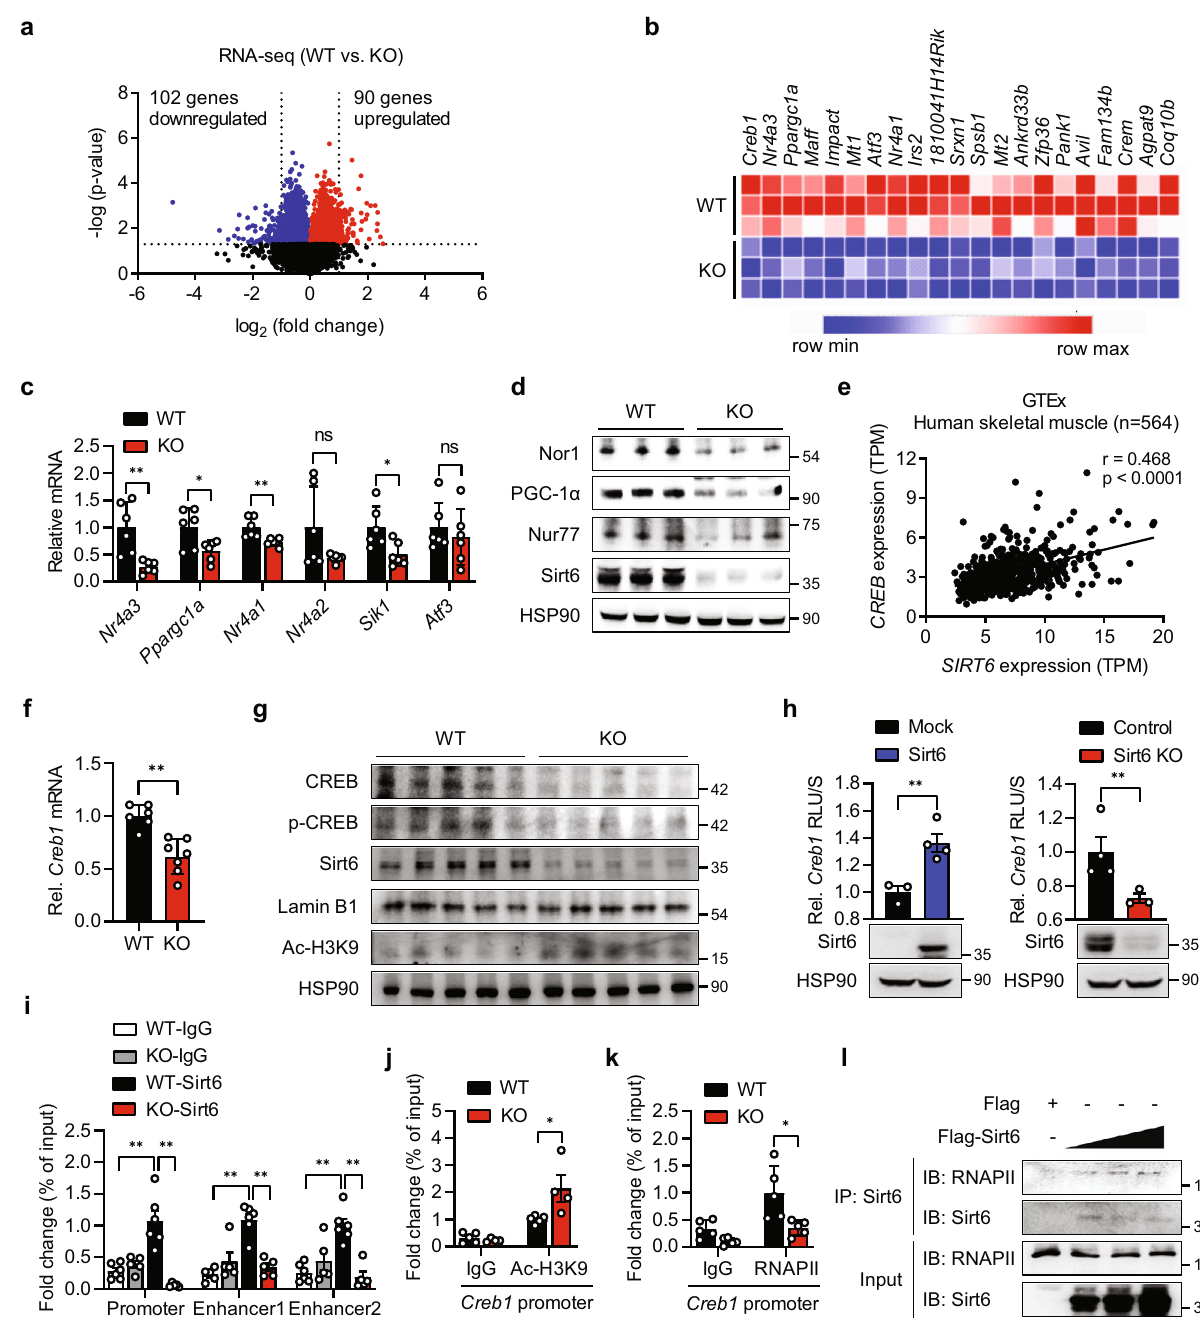
Fig. 4 Decrease in CREB pathway in muscle of Sirt6 KO mice. a Volcano plot showing the log 2 fold-difference in mRNA expression in gastrocnemius muscles (GAS) of WT and Sirt6 KO mice, assessed by StringTie analysis of RNA-seq data. Red and blue dots represent upregulated and downregulated DEGs with > 2-fold change and p < 0.05, res p ectively. Each sample was analyzed in triplicate. b Heat map of RNA-seq analysis of Creb1 and top 20 downregulated genes. c , d qPCR and Western blotting analyses of CREB target genes in GAS of mice ( n = 6). e Genotype tissue expression (GTEx) analysis of human skeletal muscle. Pearson correlation coef fi cient ( r ) between SIRT6 and CREB in human skeletal muscle were calculated. TPM, transcripts per million. f , g Creb1 mRNA and levels of the indicated protein in GAS of mice ( n = 6 for WT, n = 7 for KO). h Creb1 -luciferase reporter activities in HEK293T cells overexpressing Sirt6 or in cells with CRISPR/cas9 mediated Sirt6 knockout (KO) were measured at 24 h post-transfection and expressed as the fold change relative to Mock or Control ( n = 3 for Mock, n = 4 Sirt6, n = 4 for Control, n = 3 for Sirt6 KO). i Association of Sirt6 to Creb1 promoter or enhancers was evaluated by ChIP-qPCR in GAS of WT and Sirt6 KO mice ( n = 5 – 6). j , k ChIP-qPCR for the association of Ac-H3K9 ( n = 5 for WT, n = 4 for KO) ( j ) and RNA polymerase II (RNAPII) ( n = 5) ( k ) to Creb1 promoter in GAS of WT and Sirt6 KO mice. l HEK293T cells were transfected with increasing amount of Sirt6 and the binding of Sirt6 to RNAPII was determined. Values are mean ± SEM. Data and all images are representative of at least three independent experiments. Negative binomial Wald Test using DESeq2 ( a ), unpaired two-tailed t test between two groups ( c , e , f , h , j , k ) and one-way ANOVA followed by Bonferroni ’ s post hoc analysis ( i ) were conducted for statistical analyses. * p < 0.05 and ** p < 0.01. Source data are provided as a Source Data fi